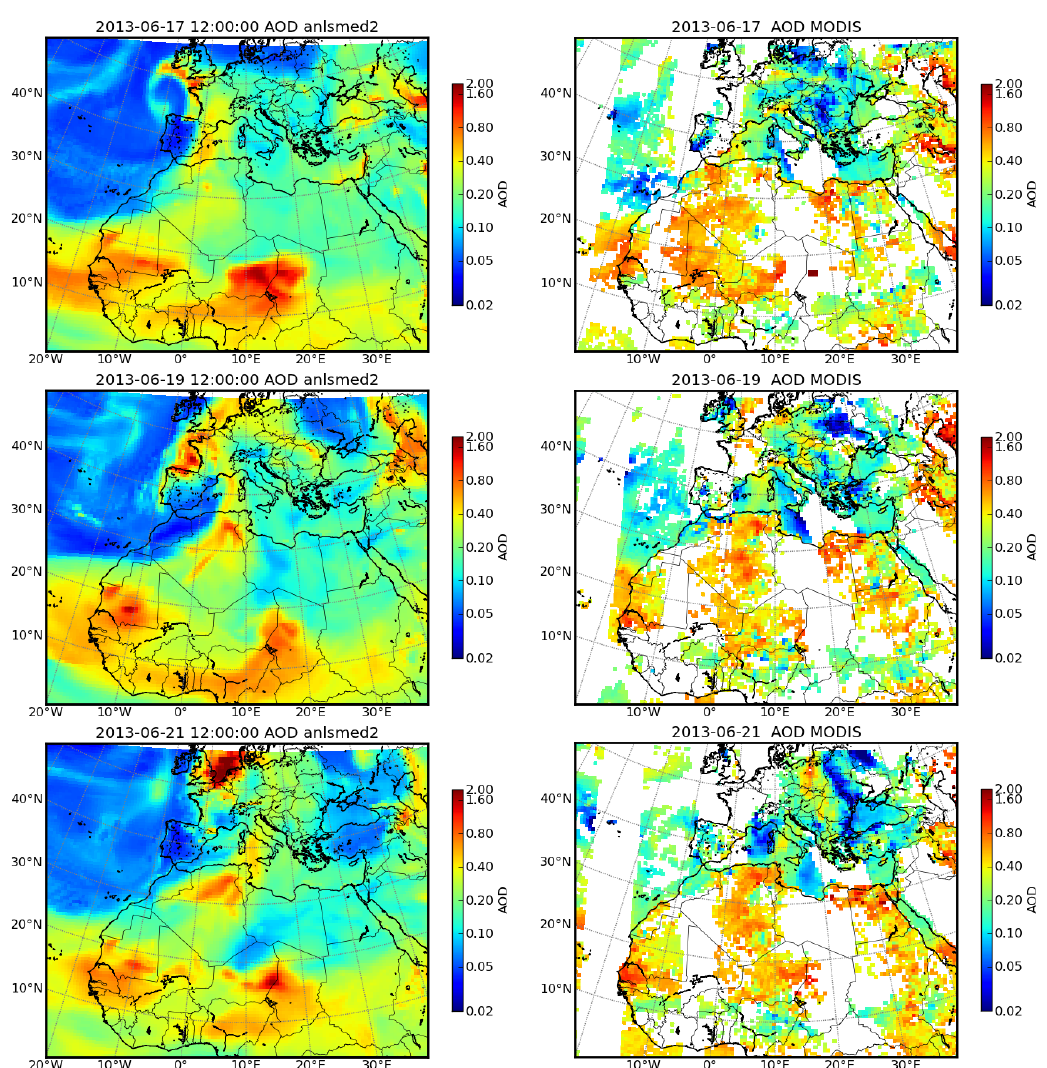
Figure 6. AOD at 550nm in the CHIMERE model (left column) and as observed by MODIS AQUA and TERRA for 17, 19 and 21 June